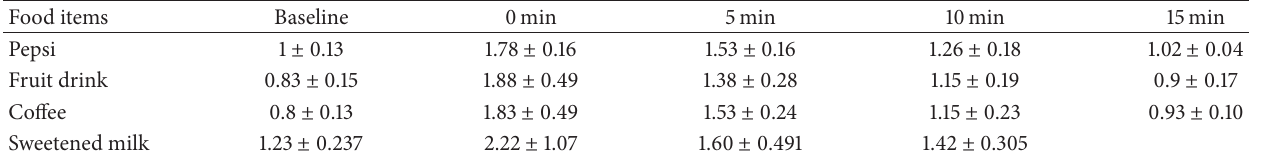
Table 2: Mean salivary flow rate at different intervals of time after consumption of different liquid food items. Food items Fruit drink